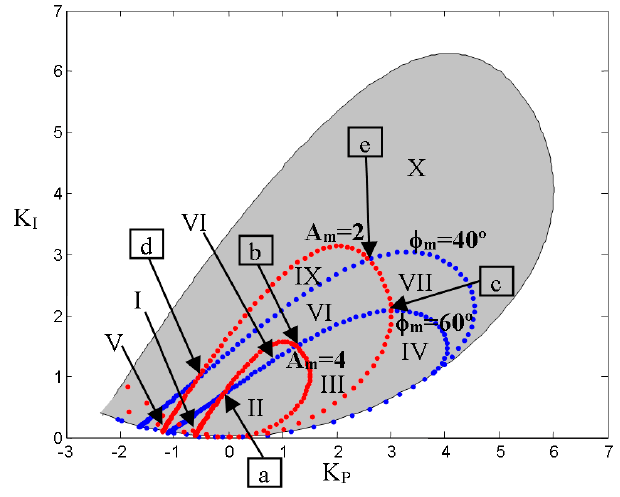
Figure 4. Stabilizing region and different boundary curves in the K P - K I parameter plane for PID α control of the non-minimum phase process in Equation (5).